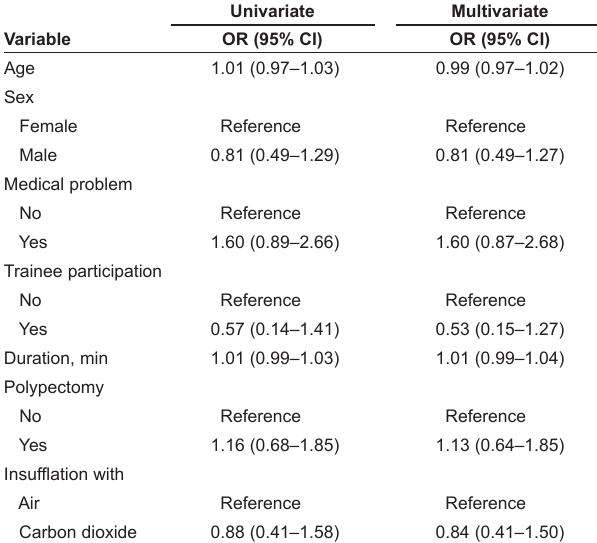
TAblE 3 Univariate and multivariate results for predictors of 30-day cumulative incidence of minor adverse events